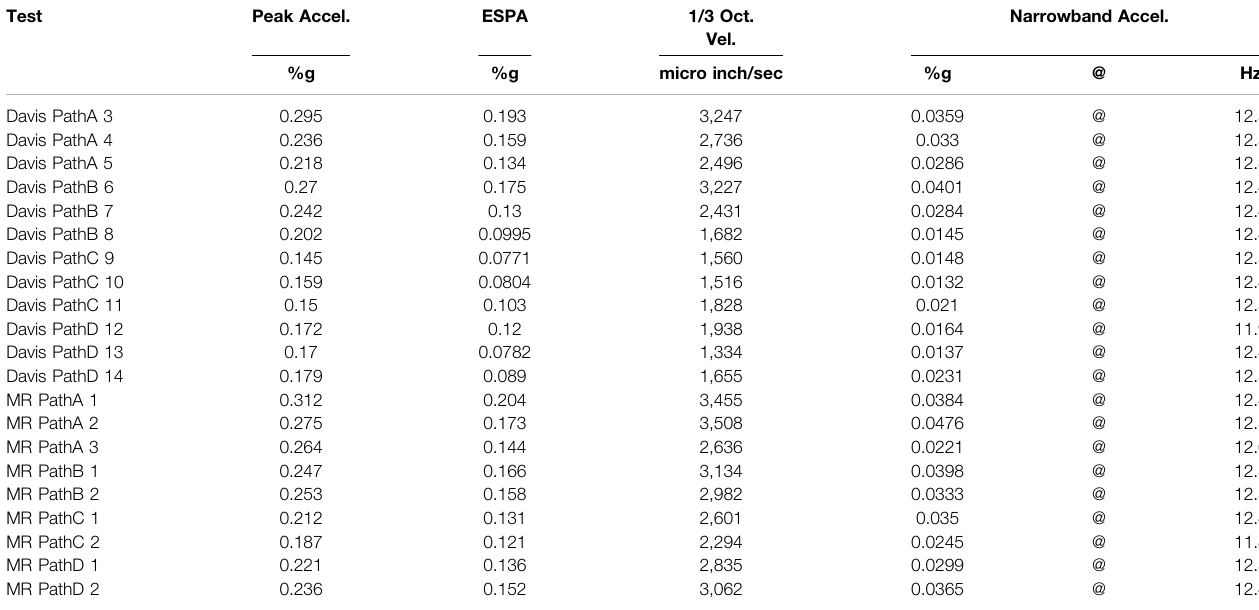
TABLE 1 | Summary of walking tests — bare slab con fi guration. Test Peak Accel. ESPA 1/3 Oct.